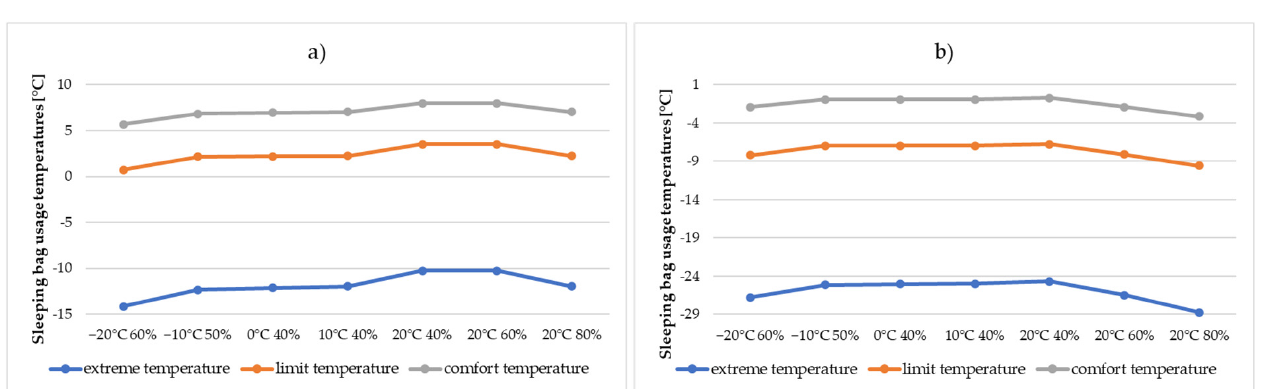
Figure 12. Comparison of lower temperatures of sleeping bags in relation to the environmental con- ditions of the tests conducted for ( a ) summer sleeping bags and ( b ) autumn sleeping bags. Table 11. Lower temperature limits in the range of utility .